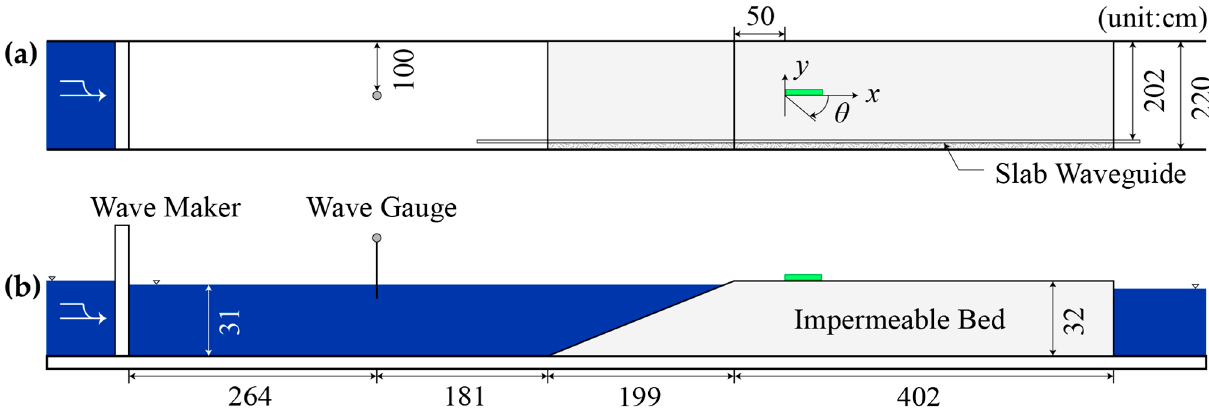
Figure 1. Experimental setup showing the impermeable bed, wavemaker, wave gauge, and slab waveguide used together with this experimental location: ( a ) plan view; ( b ) elevation view.